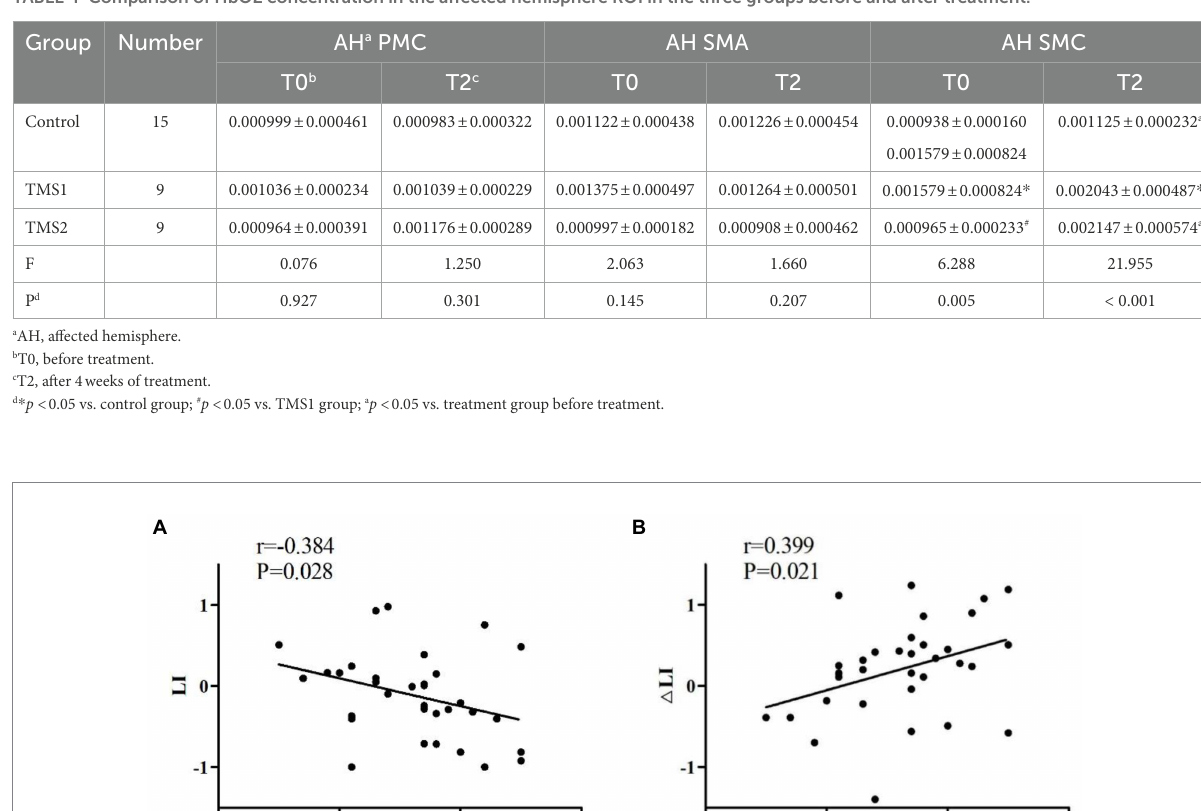
TABLE 4 Comparison of HbO2 concentration in the affected hemisphere ROI in the three groups before and after treatment.